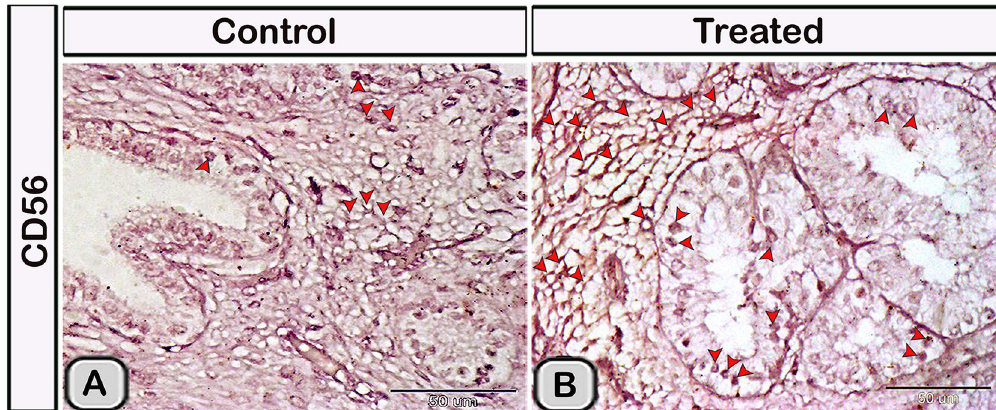
Figure 8. The effect of melatonin administration on the expression of CD56 in the DCs. (A) Expression of CD56 in the DCs lining the epithelium and the interstitium of the control groups. (B) the expression of CD56 was more abundant in the melatonin treated groups. The expression of CD56 in the interstitial DCs was branched and anastomsing similar to a continuous network.